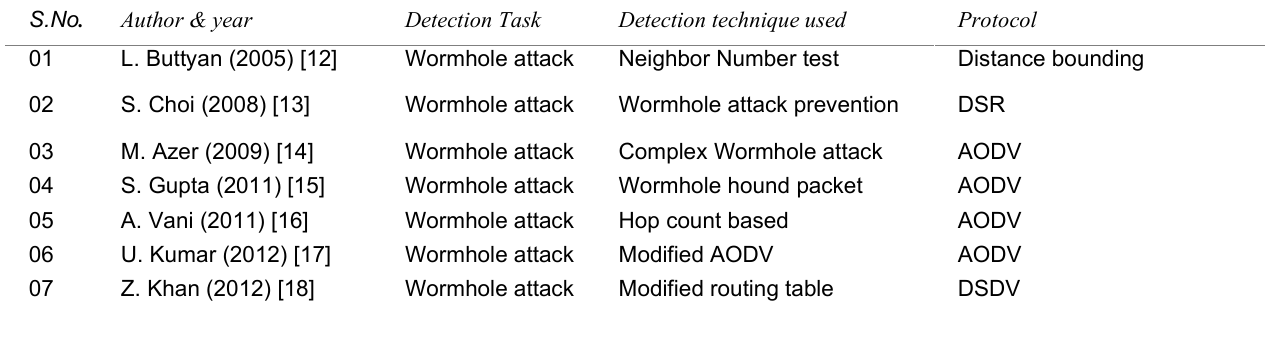
Table 1. Existing solution year